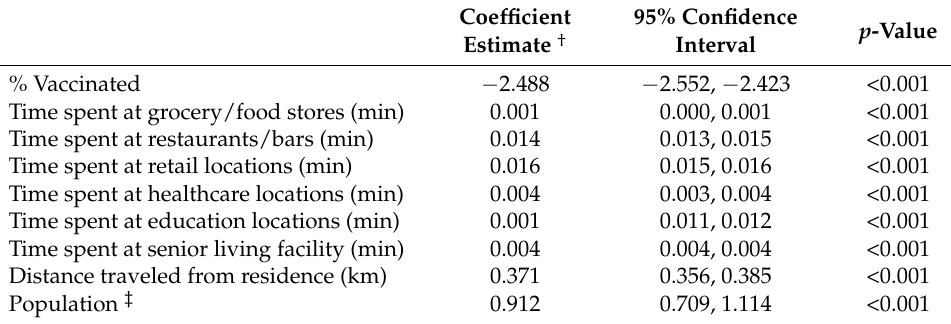
Table 1. Fixed effect estimates predicting weekly COVID-19 cases across Missouri Counties from January 2021 to July 2021.